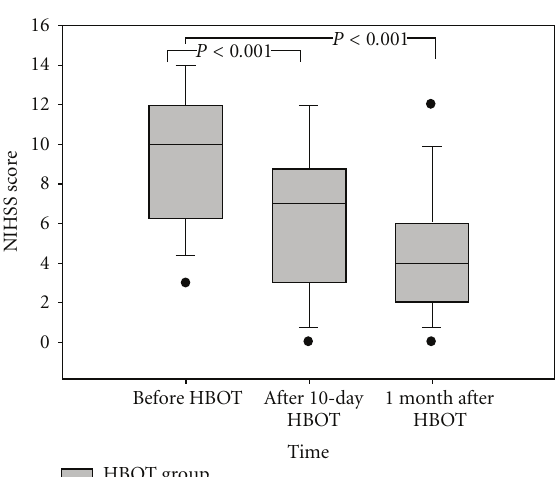
between the two groups in each item ( P value ranged from 0.063 to 0.930; Table 1).